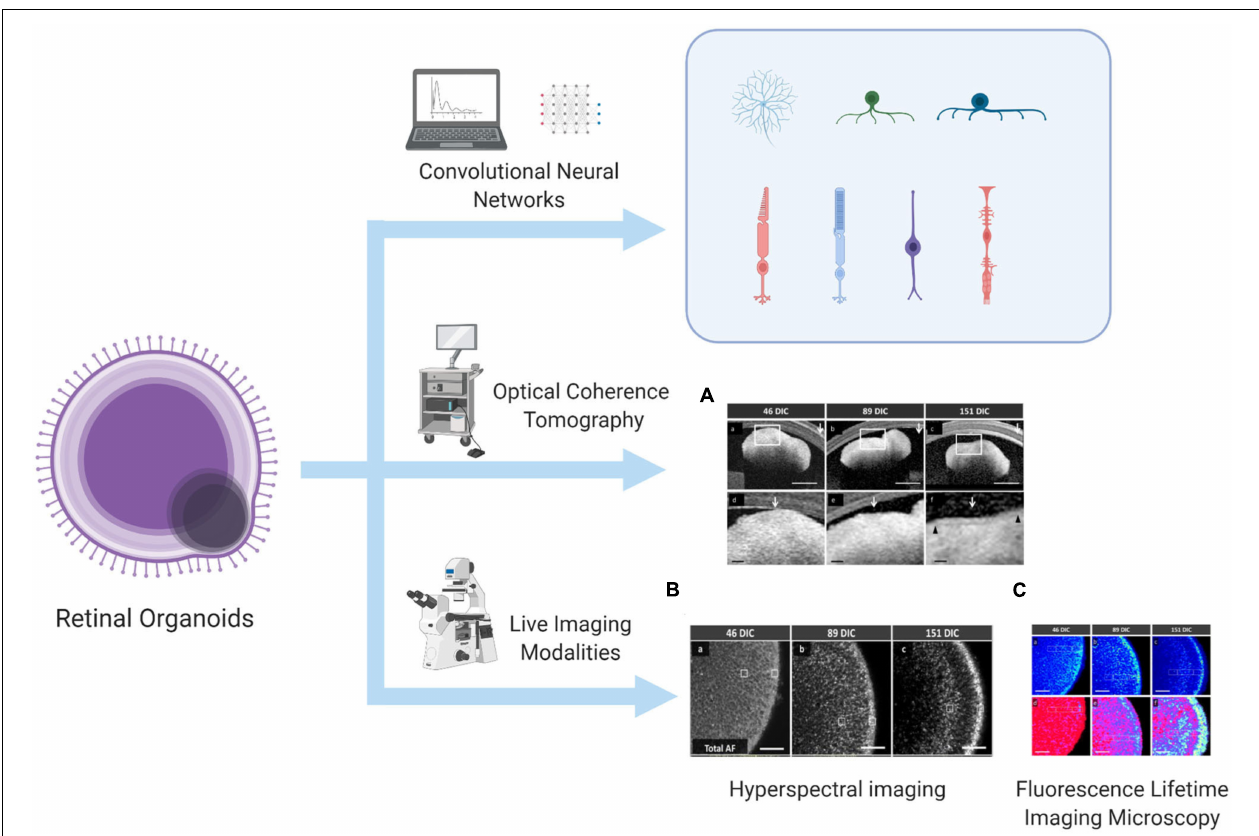
FIGURE 1 | Algorithm to predict and identify organoid differentiation, and real-time imaging modalities to monitor the metabolic status of the lamellar structure of ROs. This illustration is created by Biorender.com (A) OCT image, (B) HSpec image, and (C) FLIM image are reprinted with permission from ref (Browne et al., 2017). Copyright © 2017 Browne AW. et